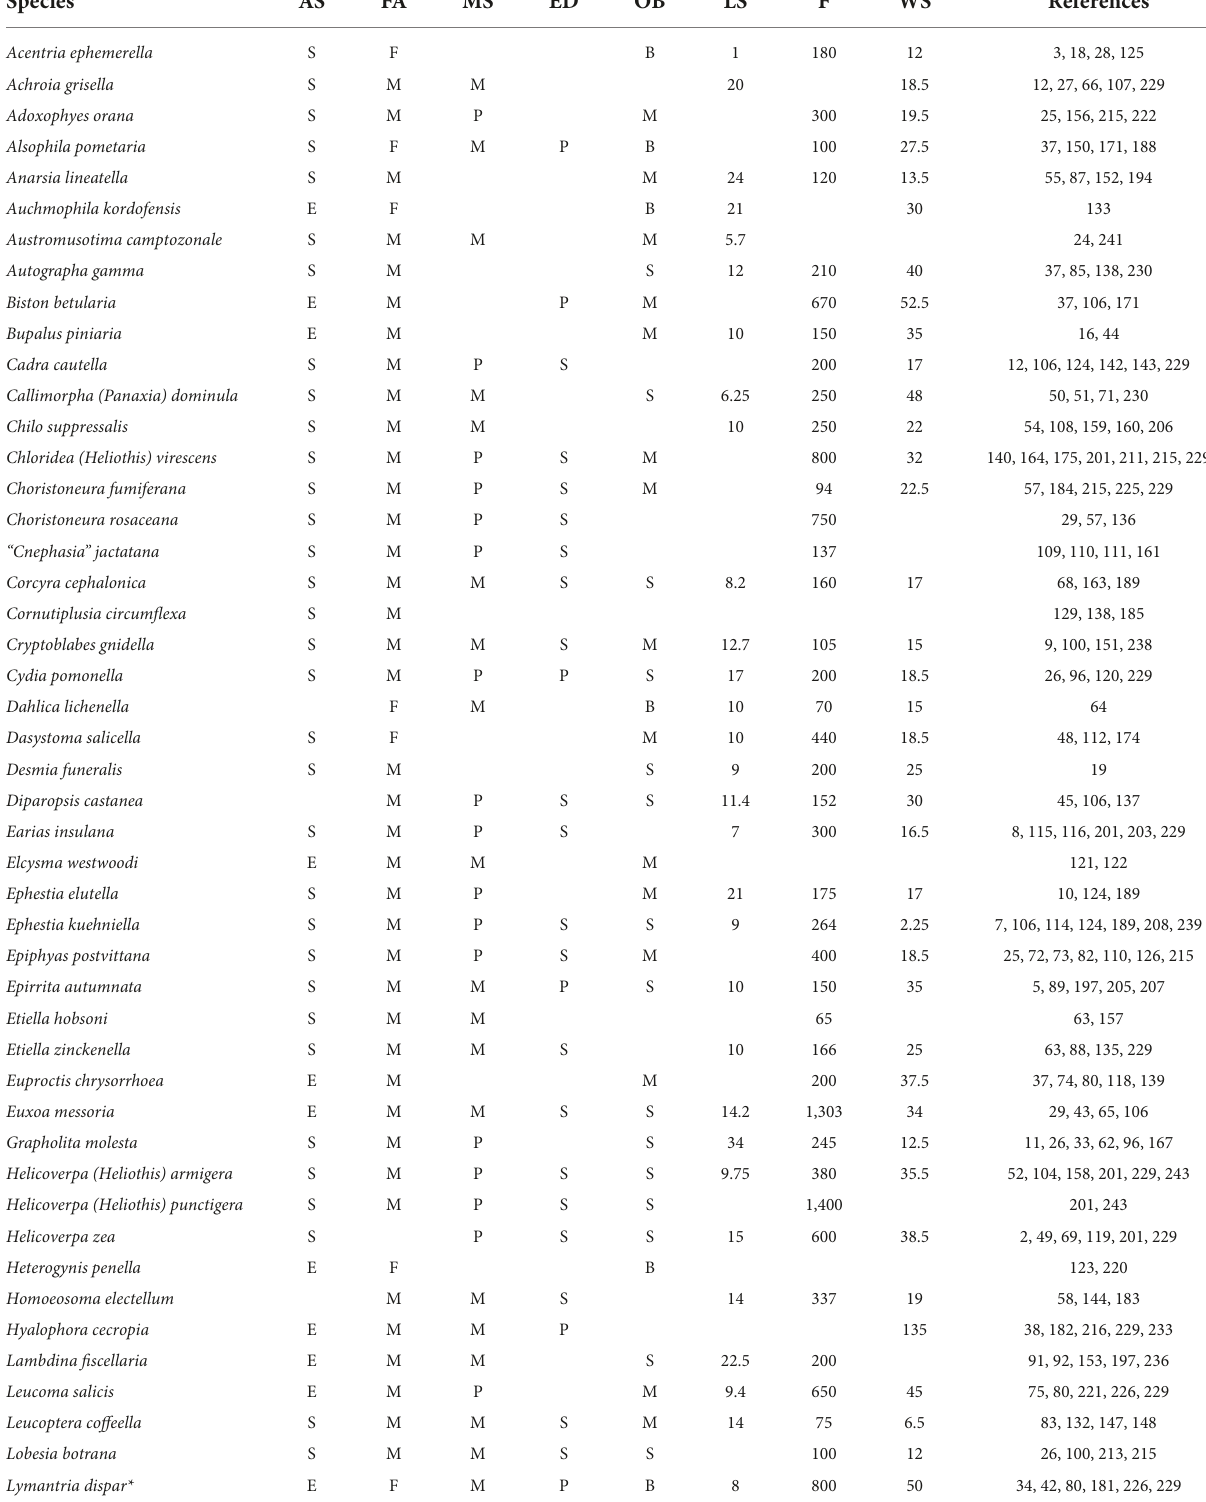
TABLE 1 Classification of species for traits